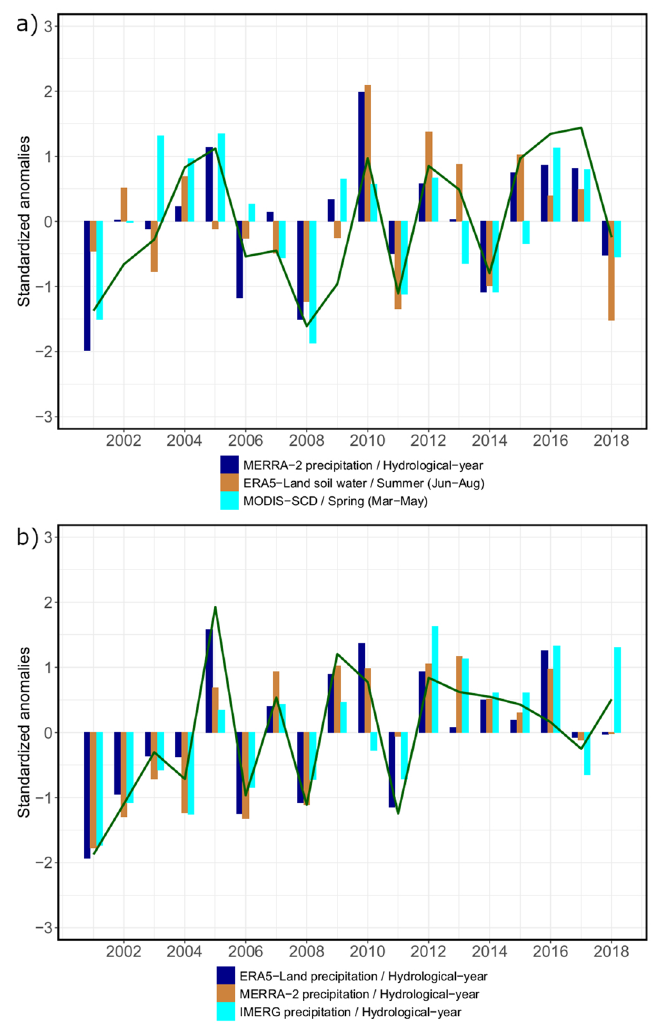
Figure 2. Standardized anomalies of the three highest correlated variables selected from different climate data products (colored bars) compared to MODIS NDVI anomalies (green line) in the Wakhan region ( a ) and the Band-e-Amir region ( b ). Created using R 4.0.3. (https ://www.R-proje ct.org/) 93